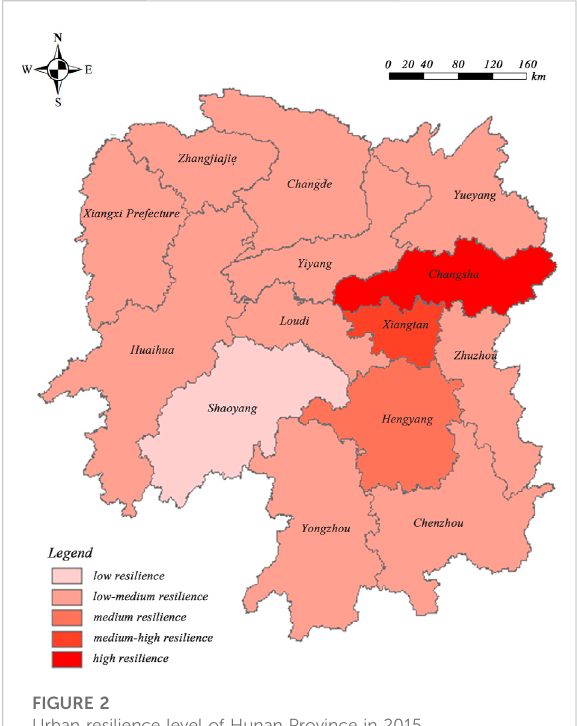
FIGURE 1 Urban resilience level of Hunan Province in 2010.